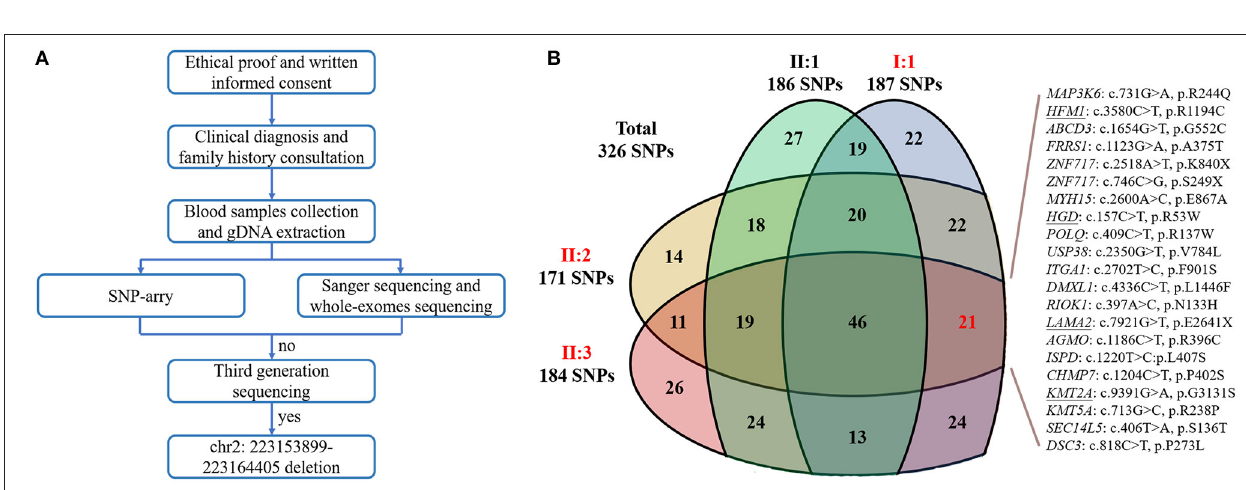
FIGURE 1 | (A) Pedigree of the WS family with three patients. The black symbols represent the affected members, and the arrow indicates the proband. (B–E) Partial phenotypes of three patients. Proband (II:3) had bilateral finger contractures with mild cutaneous syndactyly (B) , dystopia canthorum, and faint synophrys (C) ; her father (I:1) had dystopia canthorum, bright blue eyes, and prominent nasal root (D) ; her brother (II:2) had dystopia canthorum, bilateral bright blue eyes, synophrys, white forelock, and prominent nasal root (E) .